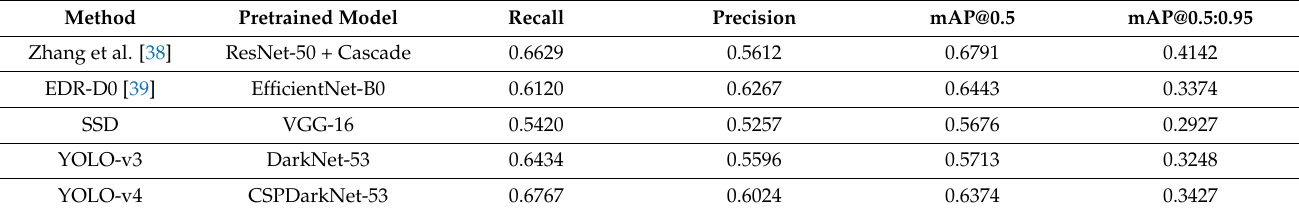
Table 3. Detection performance comparison of the proposed framework with the two-stage model proposed by Zhang et al. in [38], the EDR-D0 modal proposed by Jia et al. in [39], the classical one-stage models, and the proposed model. mAP@0.5